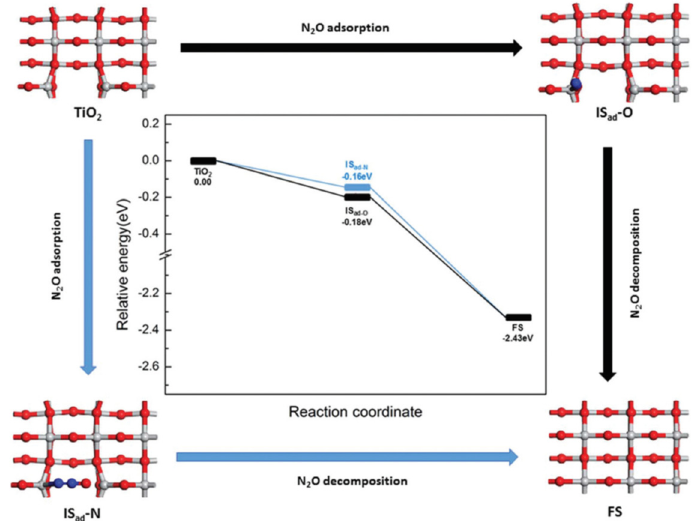
Figure 8. Decomposition of N 2 O over an anatase (001) surface containing an oxygen vacancy. Reproduced with permission from Reference [89]; copyright (2018) The Royal Society of Chemistry.